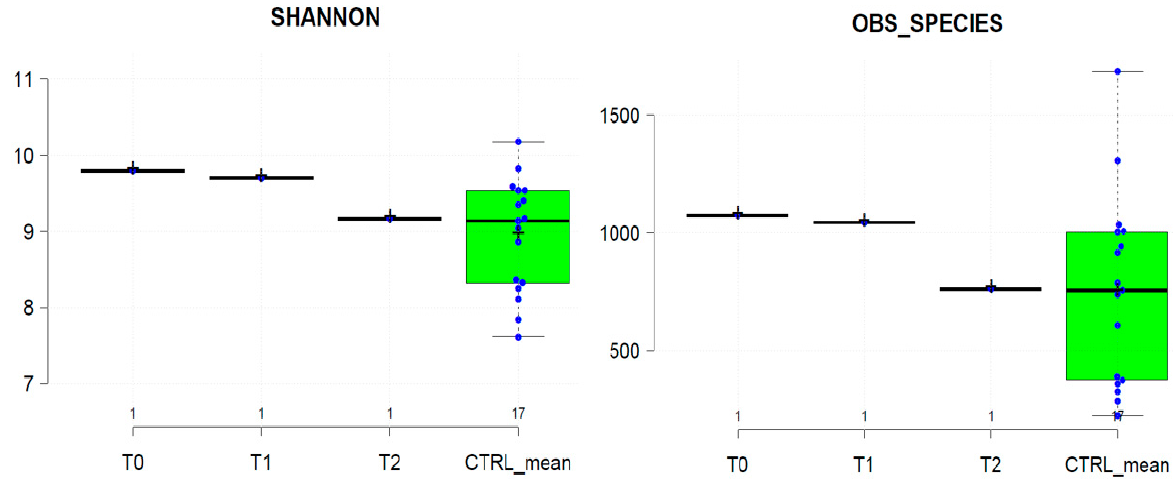
Figure 2. Alpha-diversity metrics of patient’s gut microbiota at T 0 , T 1 , T 2 , and healthy CTRL group (CTRL_mean). Left and right panels show Shannon and Observed_Species diversity indexes, respectively. Center lines show median values and box limits indicate the 25th and 75th percentiles.